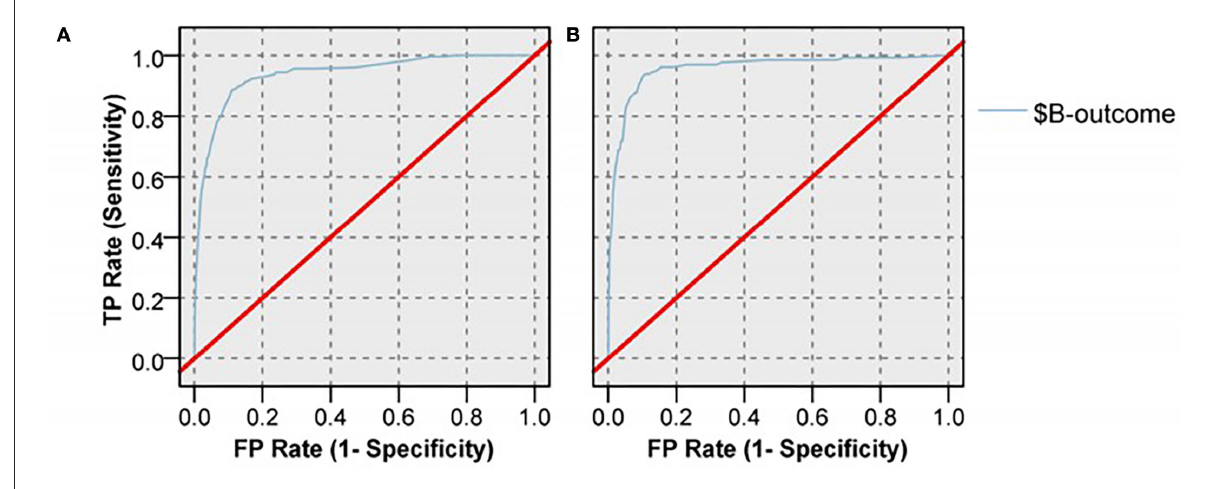
FIGURE5 ROC curve of Bayesian network model in training dataset (A) and test dataset (B) .